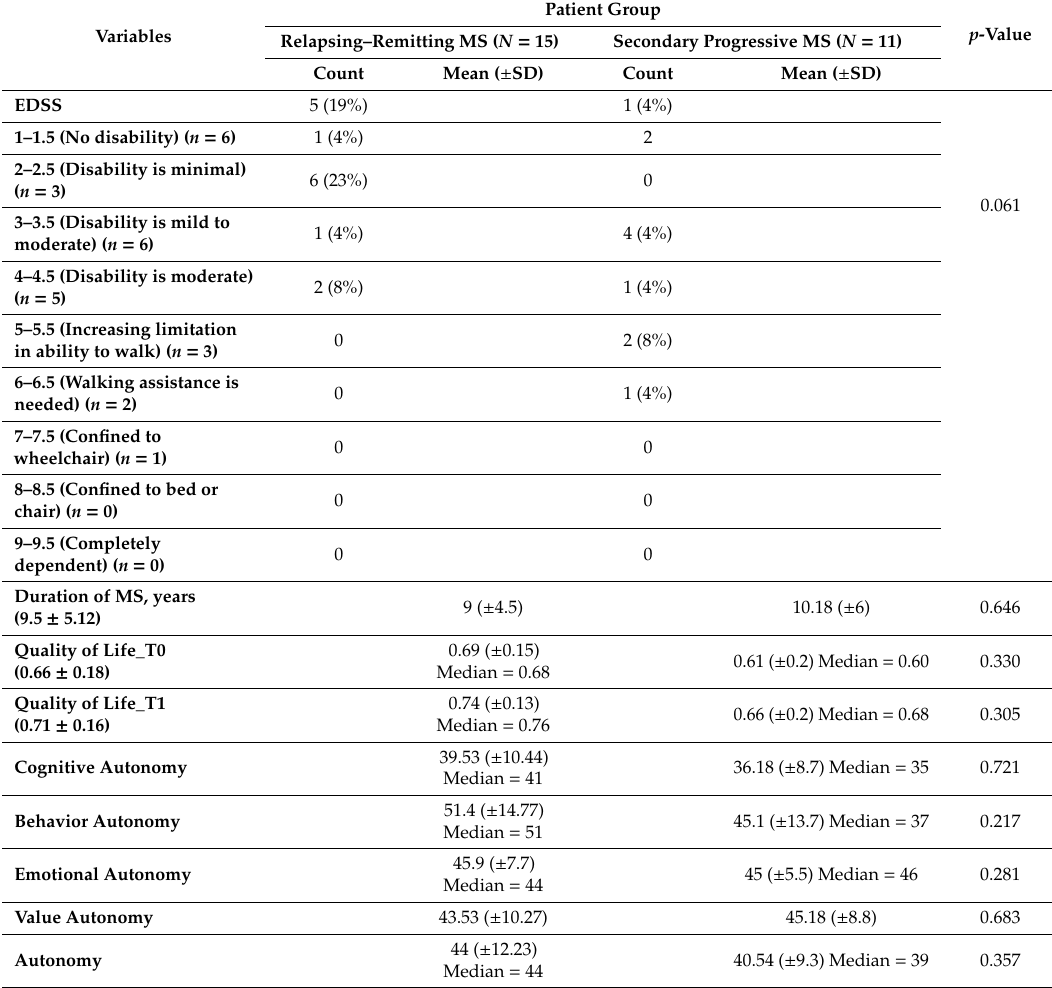
Table 2. Health status of the MS patients. EDSS, Expanded Disability Status